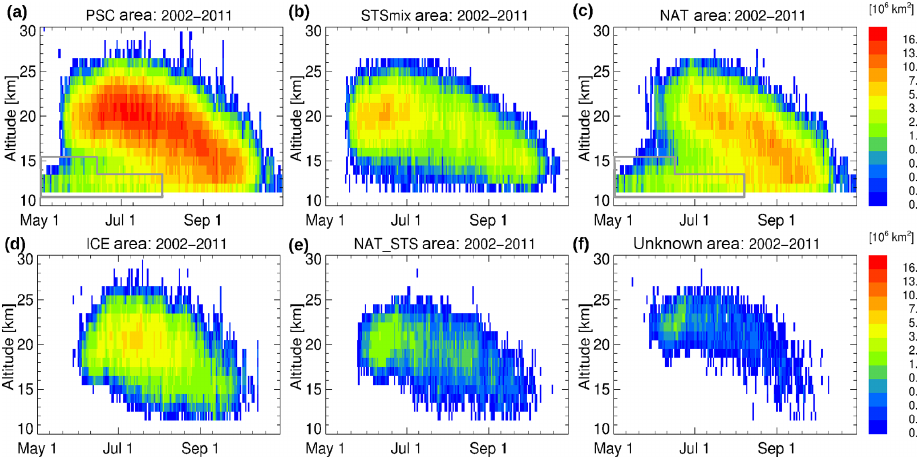
Figure 11. Time series of the 10-year mean (2002, 2003, and 2005–2011) of the daily Antarctic PSC occurrence rates weighted with the area of the applied latitude bins south of 55 ◦ S in the altitude range 12–30km. This approach is equivalent to the partition of areal coverage south of 55 ◦ S. An altitude grid of 1km with 2km grid size is applied. Presented are the overall PSC coverage in in panel (a) and all relevant classes of the Bayesian classifier STSmix, NAT, ICE, NAT_STS, and unknown in panels (b–f) . The grey boxes in the early winter period highlight regions where polar cirrus at the tropopause and potentially some volcanic aerosols introduce a bias in the PSC detection and